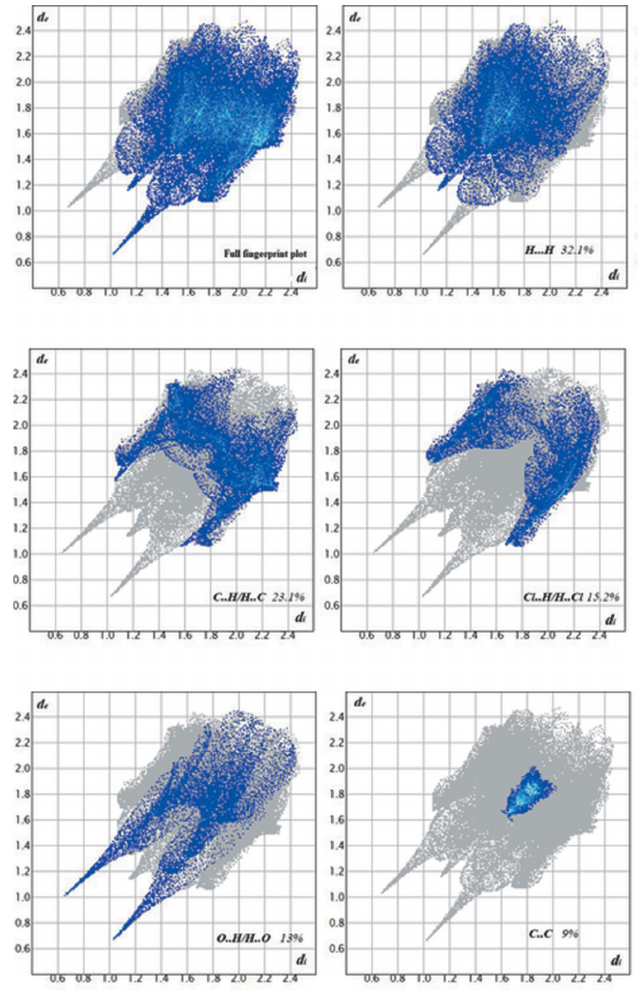
Figure 5 The full fingerprint plot for title compound and those delineated into